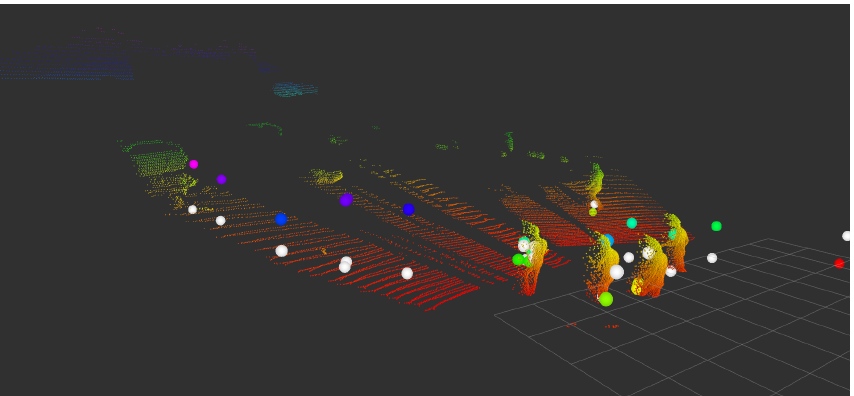
Figure 15. A lidar pointcloud of a parking lot is shown, with white spheres representing the corrected outdoor radar dataset and colored spheres representing the radar dataset before